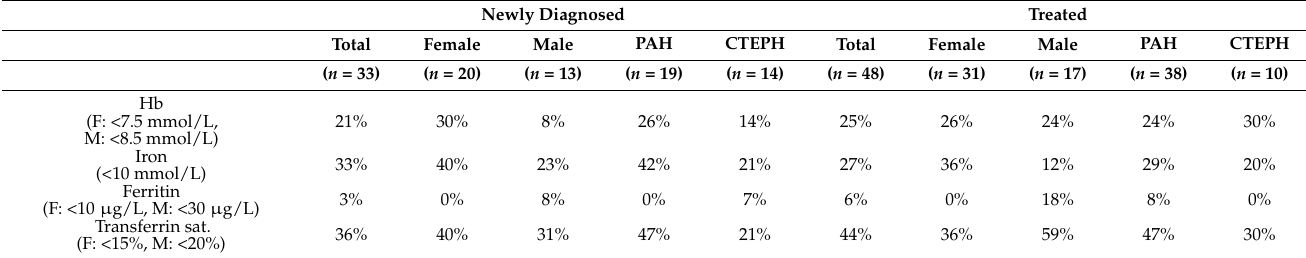
Table 5. Percentage of patients below the reference value for iron-related factors in newly diagnosed and treated patients, split by gender and disease